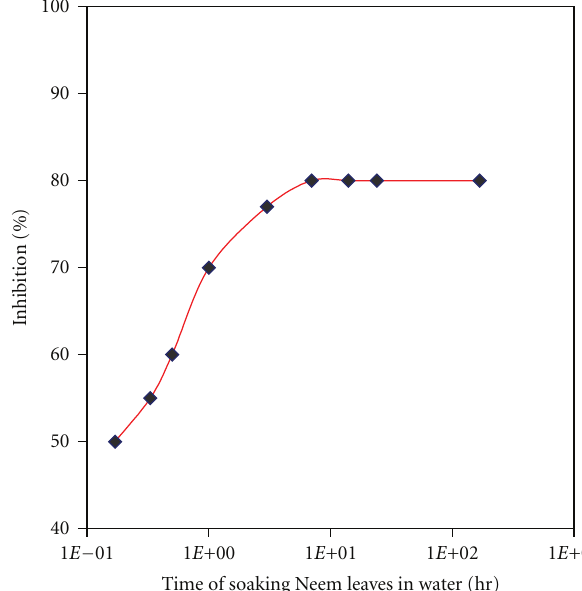
Figure 1: The e ff ect of soaking time of Neem leaves in distilled water on the percentage inhibition.